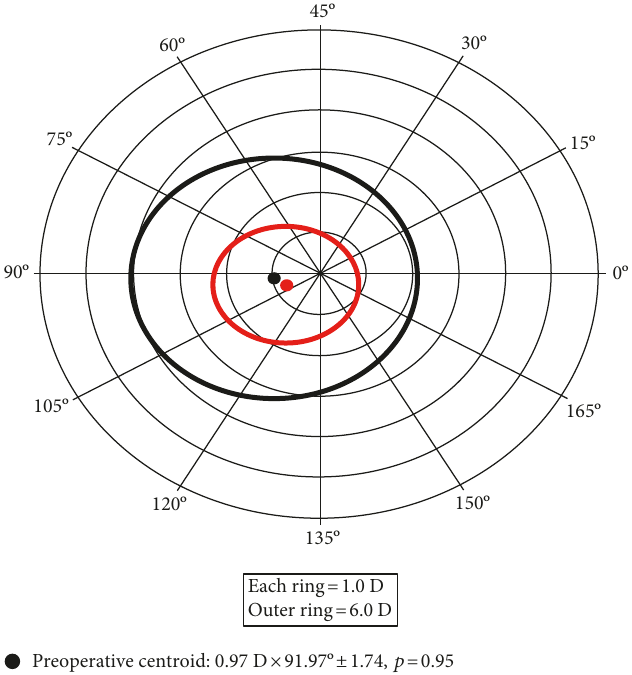
Preoperative centroid: 0.97 D × 91.97 º ±1.74, p =0.95 Figure 4: Relationship between preoperative and postoperative keratometric astigmatism. The standard deviation is represented by the area around the centroid ( p =shape factor ) . Each ring =1.0 D/outer